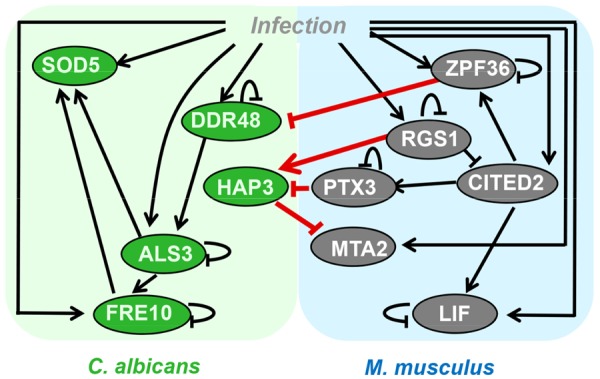
Network model describing pathogen-host interactions between C. albicans and murine dendritic cells based on dual RNA-Seq data (modified from Tierney et al., 2012b).